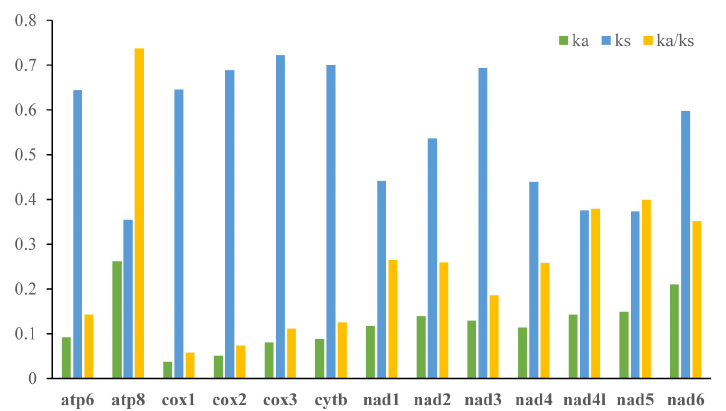
Figure 3. Evolutionary rates of 13 PCGs in 94 moths. Rate of non-synonymous substitutions (Ka), rate of synonymous substitutions (Ks), and ratio of rate of non-synonymous substitutions to rate of synonymous substitutions (Ka/Ks) are calculated for each PCG.